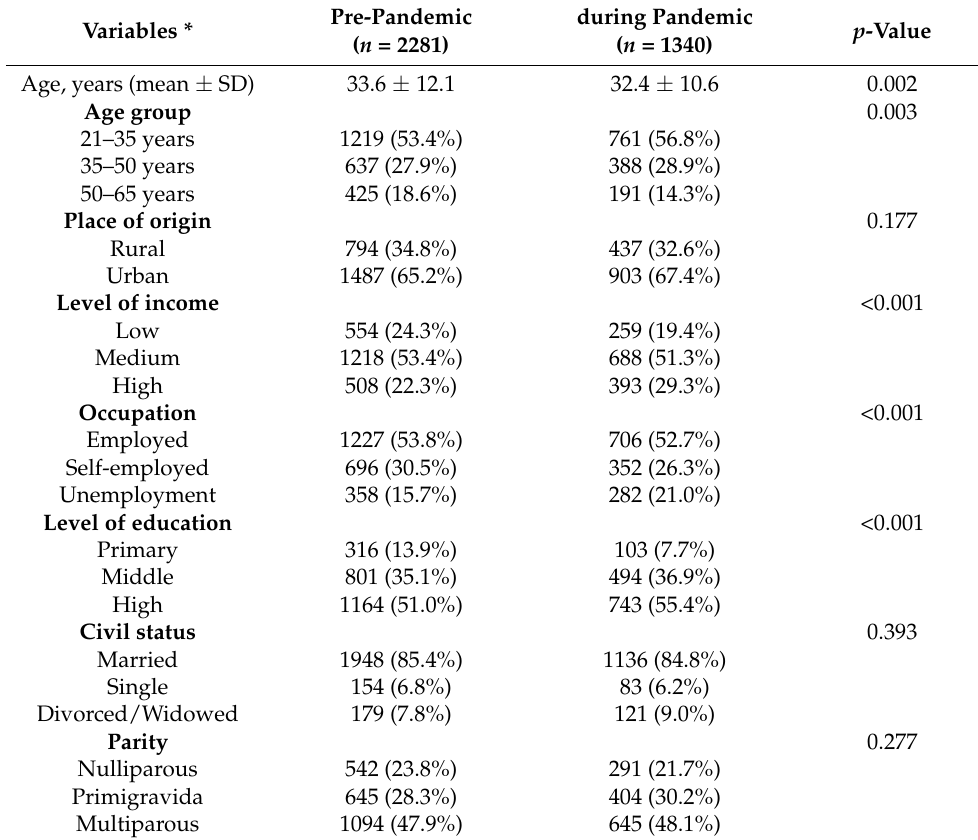
Table 1. General characteristics of patients presenting in the outpatient setting for cervical cancer investigations and treatment before and during the COVID-19 pandemic. Pre-Pandemic during Pandemic p Variables * ( n = 2281) ( n = 1340)